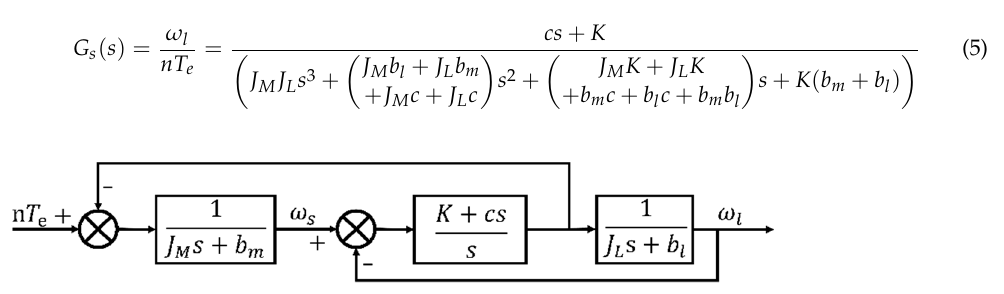
Figure 3. Control block diagram of the two-inertia elastic system.